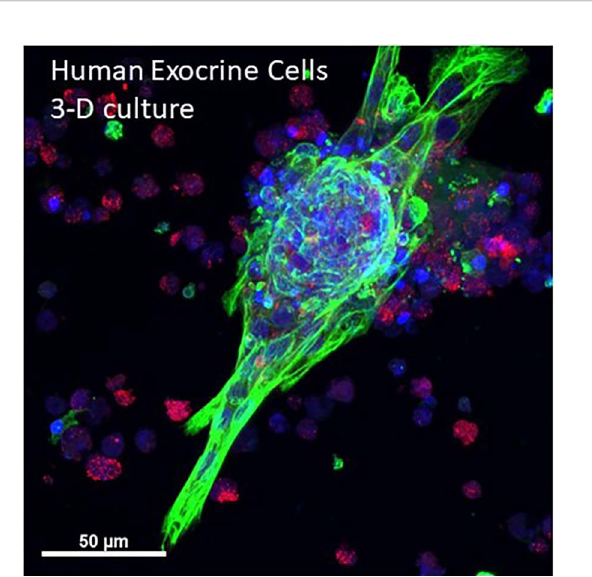
FIGURE 5 | 3-D projection human primary pancreas exocrine cells in culture. Isolated human exocrine cells were obtained from a pancreas donor non-islet fractions and following fi ltration to remove islets and clumps, exocrine cells were plated in 1:1 DMEM:F12 and Matrigel and grown for 6 days. A maximum projection image shows ductal cells (cytokeratin 19, green), acinar cells (amylase, red) and nuclei (blue). Cells were kindly provided by Dr. Thomas Schmittgen, College of Pharmacy, University of Florida. See also Supplementary Video 4 for entire 3-D z-stack (12